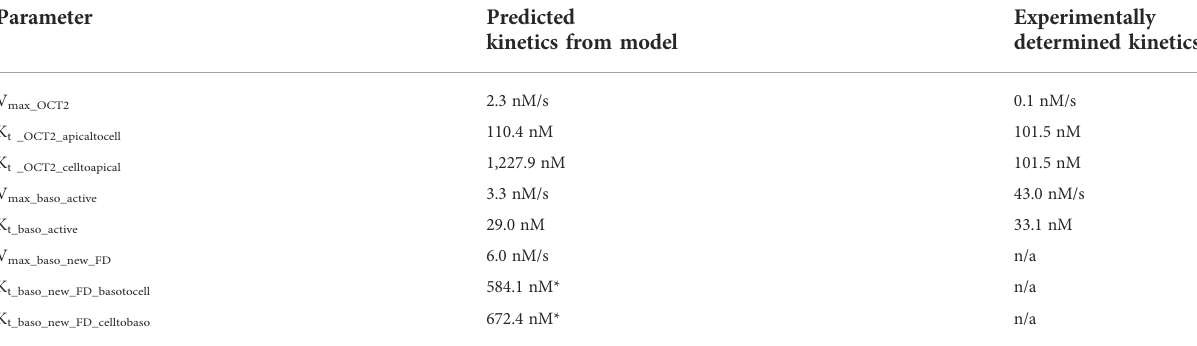
TABLE 1 Required facilitated diffusion transporter kinetics for modelling of experimentally determined concentration-time relationships of TYR in each compartment.